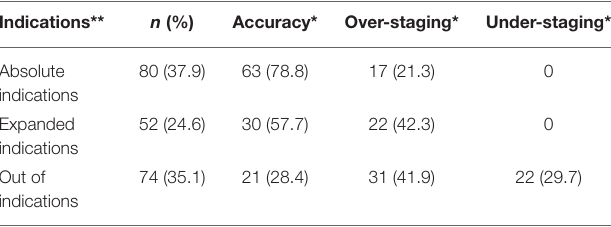
TABLE 6 | Accuracy of EUS for predicting cancer invasion depth according to the indications for endoscopic